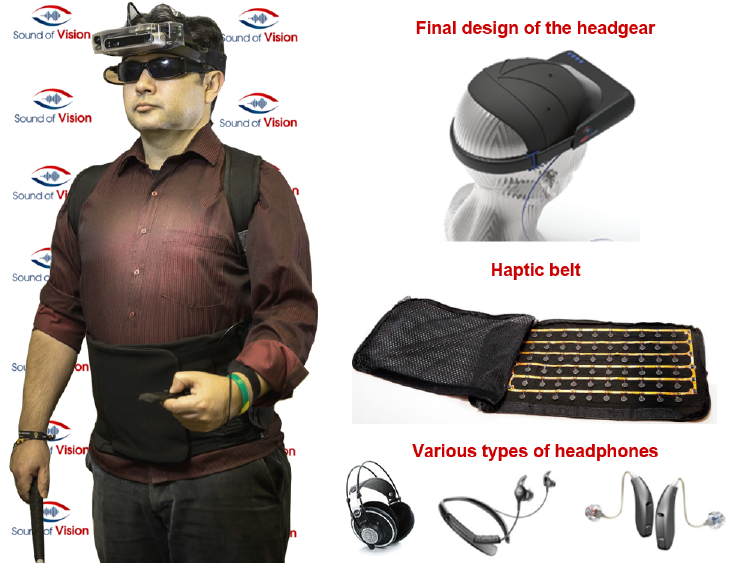
Figure 1. The Sound of Vision system. ( Left ) The prototype used in the usability evaluations. ( Right ) Various parts of the